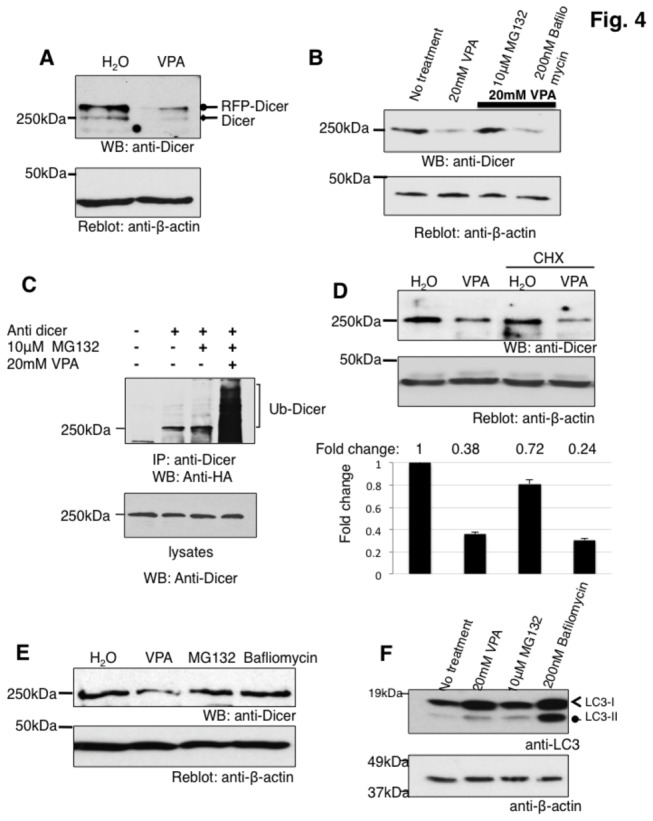
VPA leads to a degradation of the RNAse III DICER.
A. Influence of VPA on DICER over expressed as a cDNA. HEK293 cells were transfected with RFP-tagged DICER and treated for 16 hours with 20 mM VPA. Proteins were separated on SDS page and analyzed by western blot using anti-DICER antisera.
B. Proteasome inhibitors block the action of VPA on DICER.HEK293 cells were treated with 20 mM VPA in the presence of the proteasome inhibitor MG132 (10 µM), as well as the lysosome inhibitor bafliomycin A1 (200 nM) for 16 hours. Expression of endogenous DICER was detected using Western blot (top) and compared to ß-actin expression (bottom). The quantification is shown in Figure S5.
C. Ubiquitination of DICER: HEK293 cells were transfected with a HA-tagged ubiquitin expression vector, in the presence of 10 µM MG132. Endogenous DICER was immunoprecipitated using anti-DICER antiserum, and analyzed with an anti-HA antiserum. VPA treatment was for 16 hours. The western blot with anti-DICER antiserum is shown below.
D. Effect of VPA on cells after inhibition of translation. Cells were treated with cyclohexamide (100 mg/l) and 20 mM VPA for 12 hrs and DICER protein levels detected by western blot. ß-actin was used to demonstrate loading. The quantification underneath shows the fold change relative to the water control, set to 1, n=3.
E. HEK293 cells were treated with 20 mM VPA, 10 µM MG132 and 200 nM bafliomycin A1 and DICER was detected by western blot. ß-actin was used as a loading control. The signal for DICER relative to actin was set to 1, VPA:0.36; MG132:0.93; Bafliomycin: 1.
F. Response of LC3 protein levels to bafliomycin, MG132 and VPA treatment. Cells were treated for 12 hours with the drugs and the conversion of LC3-I to LC3-II was monitored by Western blot.